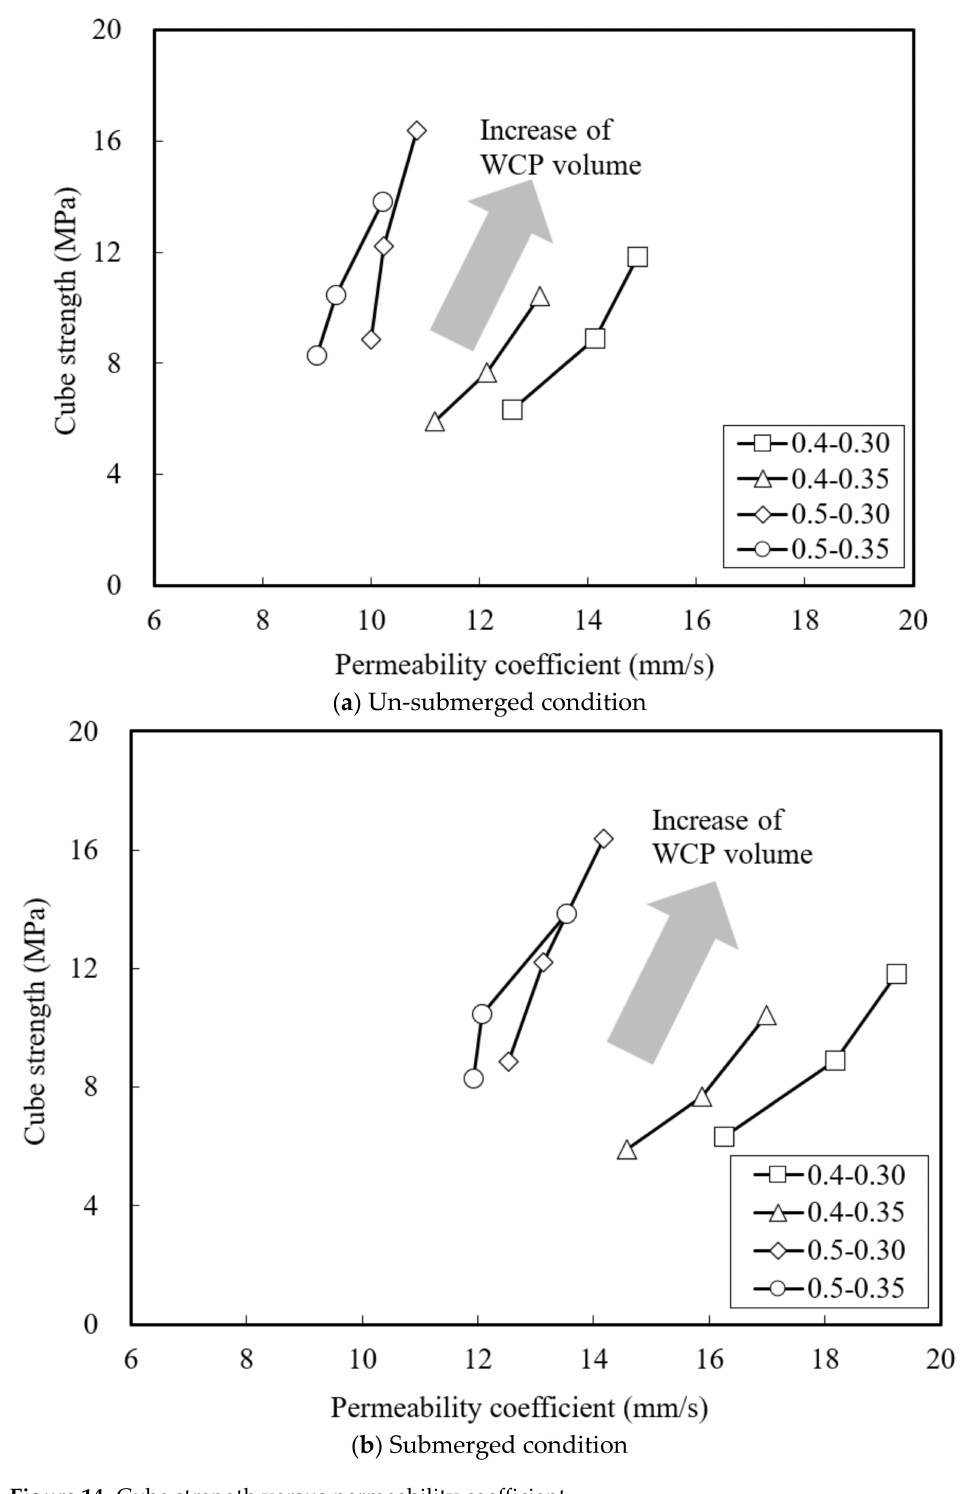
Figure 14. Cube strength versus permeability